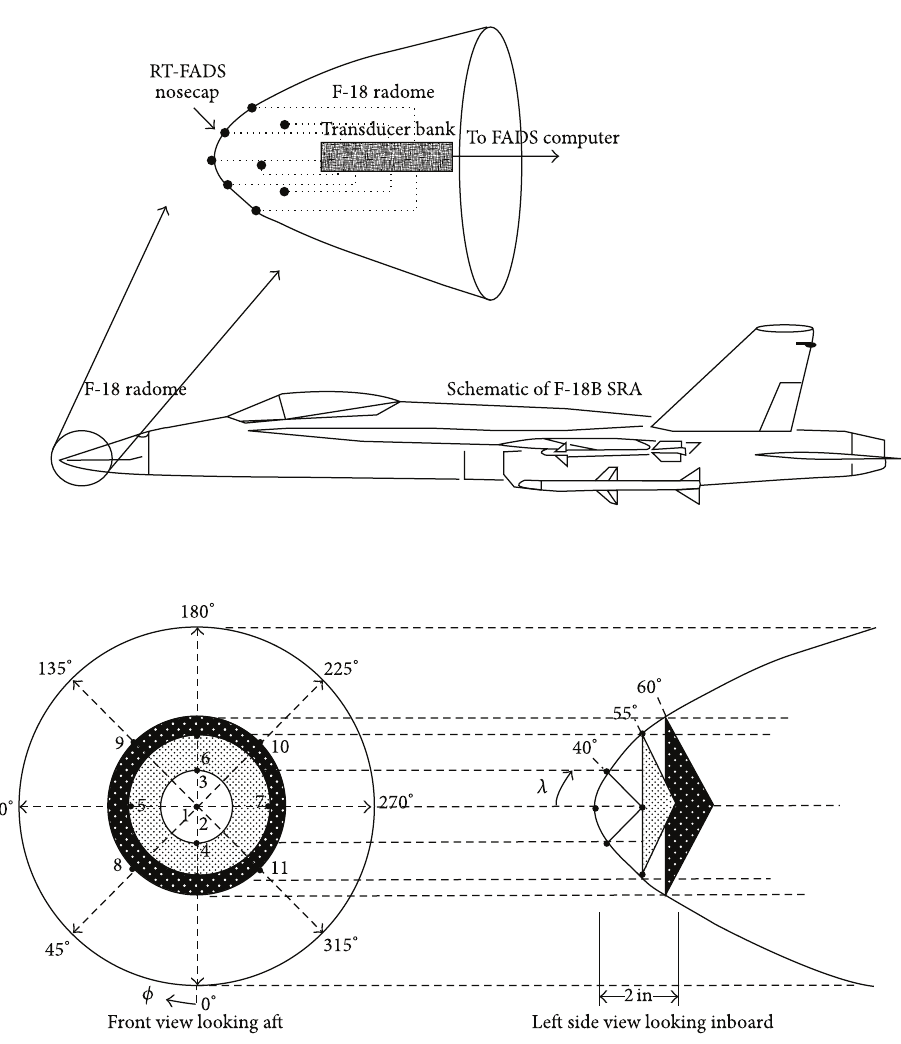
Figure 1: Flush air data system installation at the nose of the F-18 Systems Research Aircraft [1].